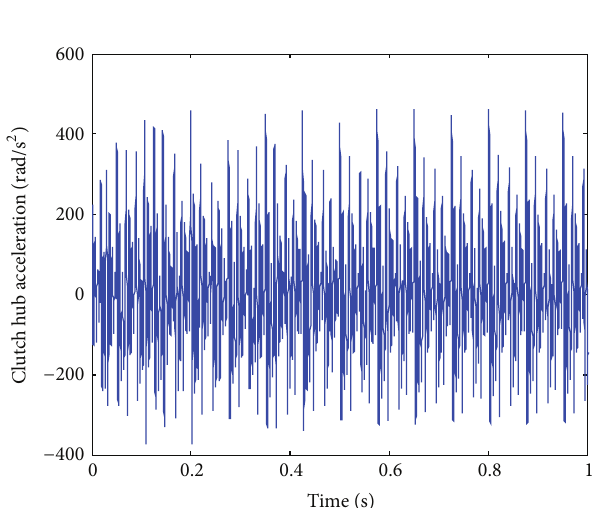
Figure 25: Angular acceleration of the clutch hub.